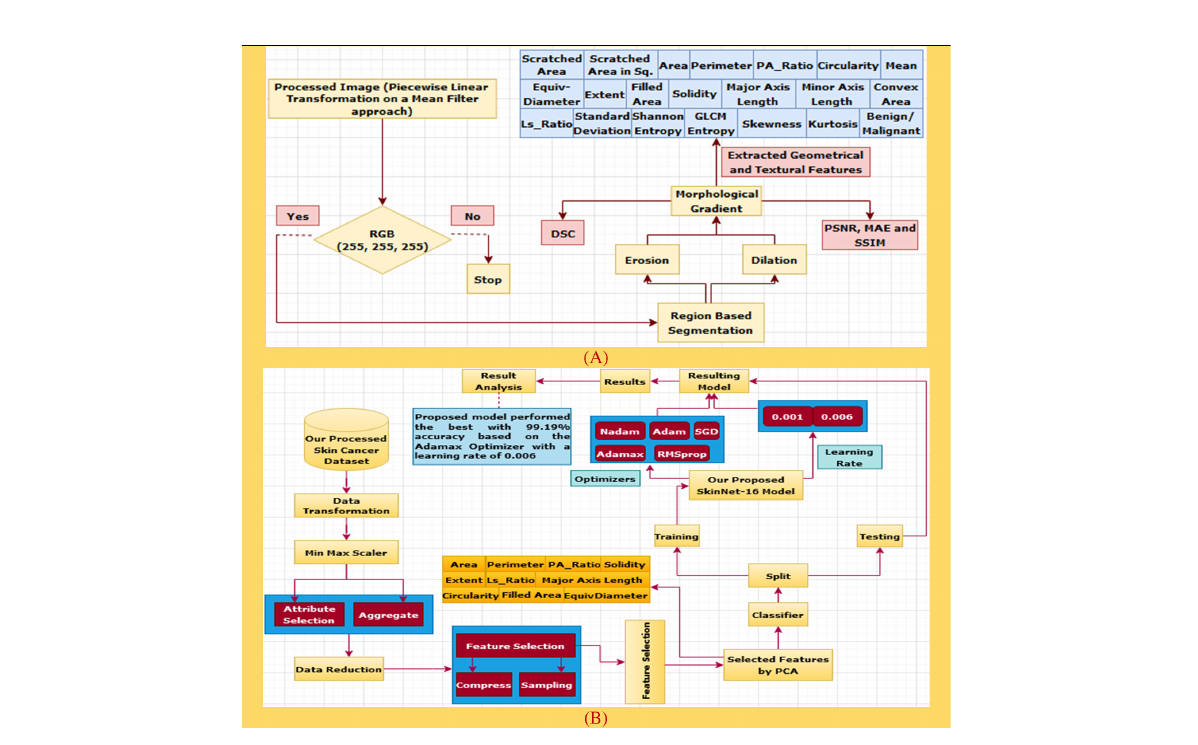
FIGURE 6 (A) The process of data construction. (B) A performance analysis diagram based on the extracted features of